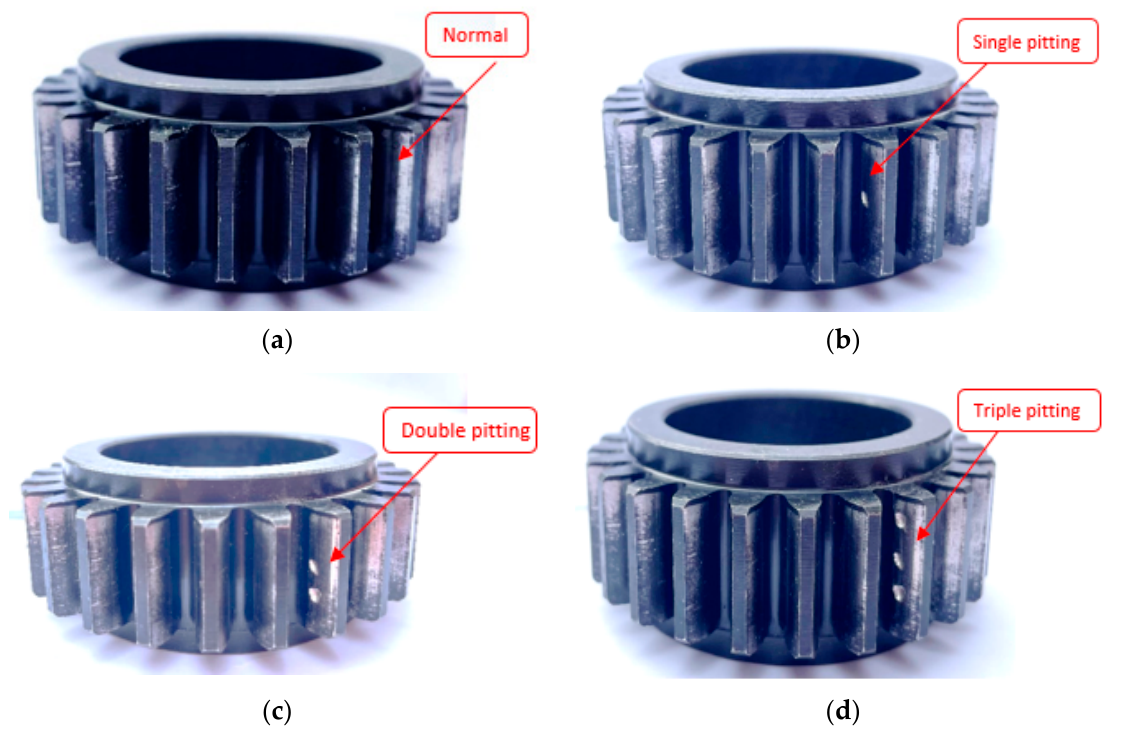
Figure 12. Gears with different degrees of pitting. ( a ) Normal condition, ( b ) single pitting condition, ( c ) double pitting condition, ( d ) triple pitting condition.